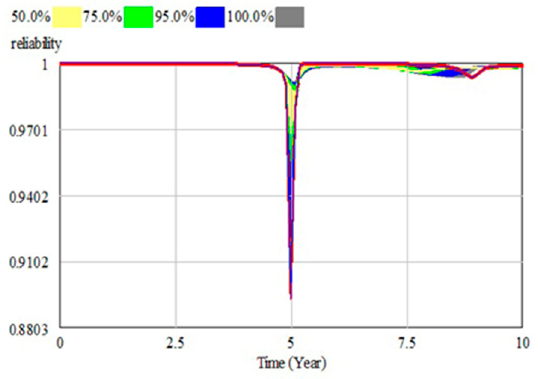
Figure 26. SD sensitivity trace range of ‘reliability’ variable.